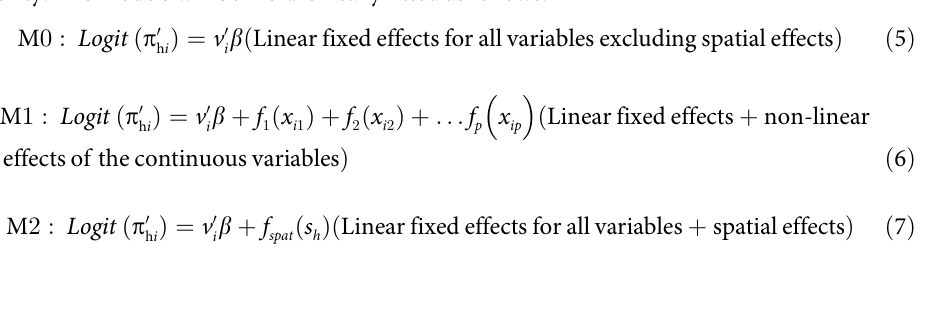
ð Linear fixed effects þ